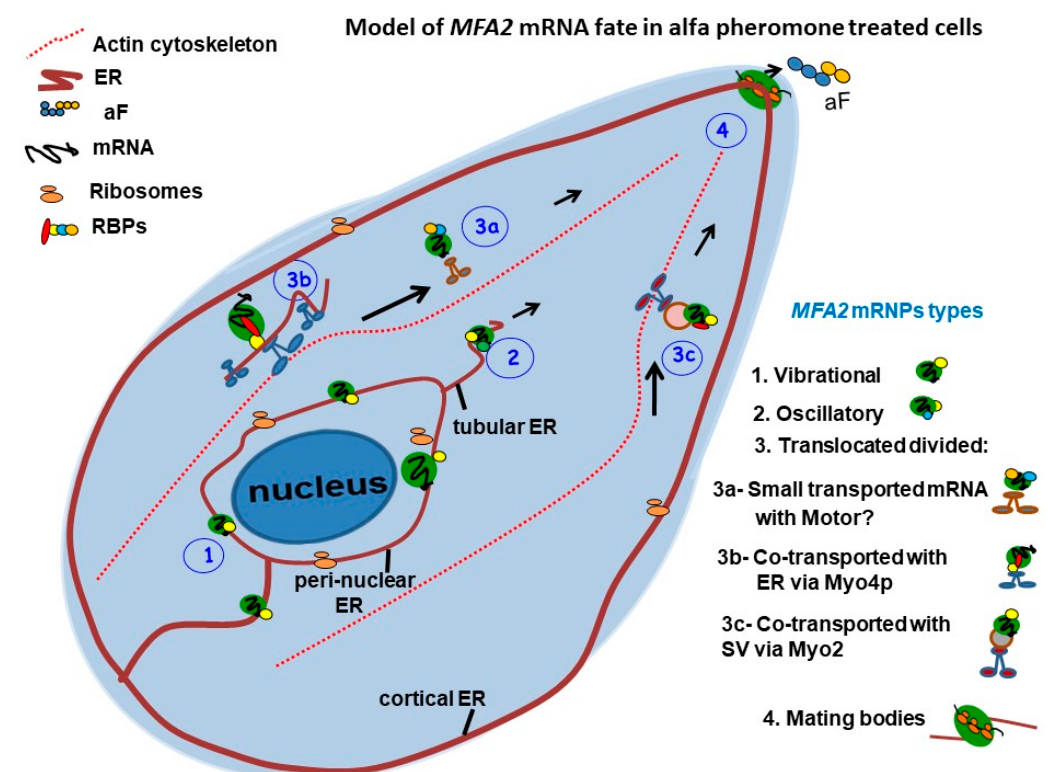
Figure 10. Model of MFA2 mRNA fate in alfa pheromone-treated cells.